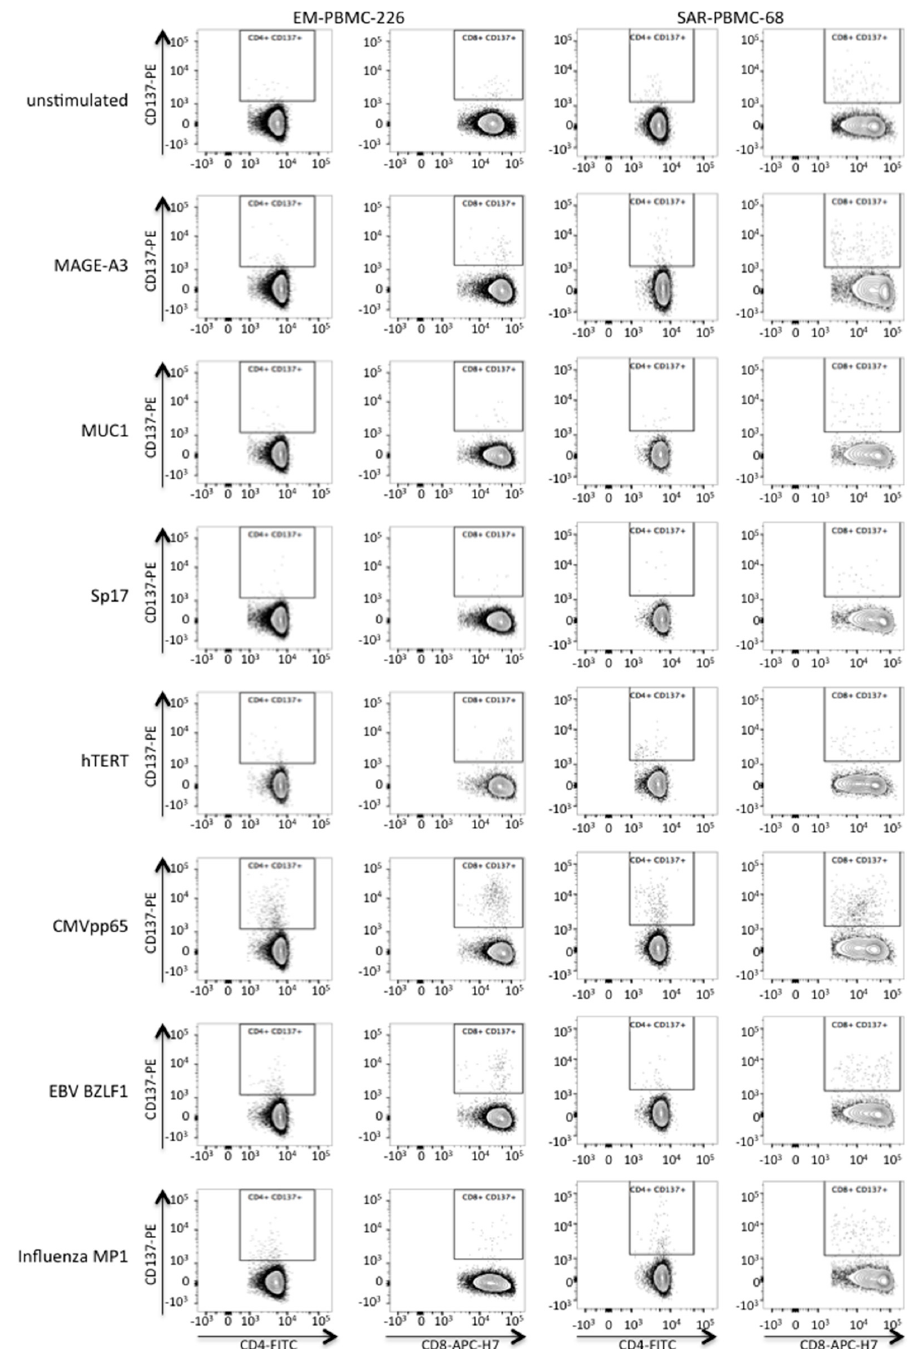
Figure 4. Flow cytometric analysis of antigen-specific T cell responses. For two patients, representative dot plots are shown of CD4 + CD137 + and CD8 + CD137 + T cells after ex vivo stimulation with the indicated overlapping peptide pools. Cells are gated on either CD3 + CD4 + CD8 − CD19 − cells or on CD3 + CD4 − CD8 + CD19 − cells within the live PBMC gate, as described in the Experimental Section and as depicted in Figure S1.